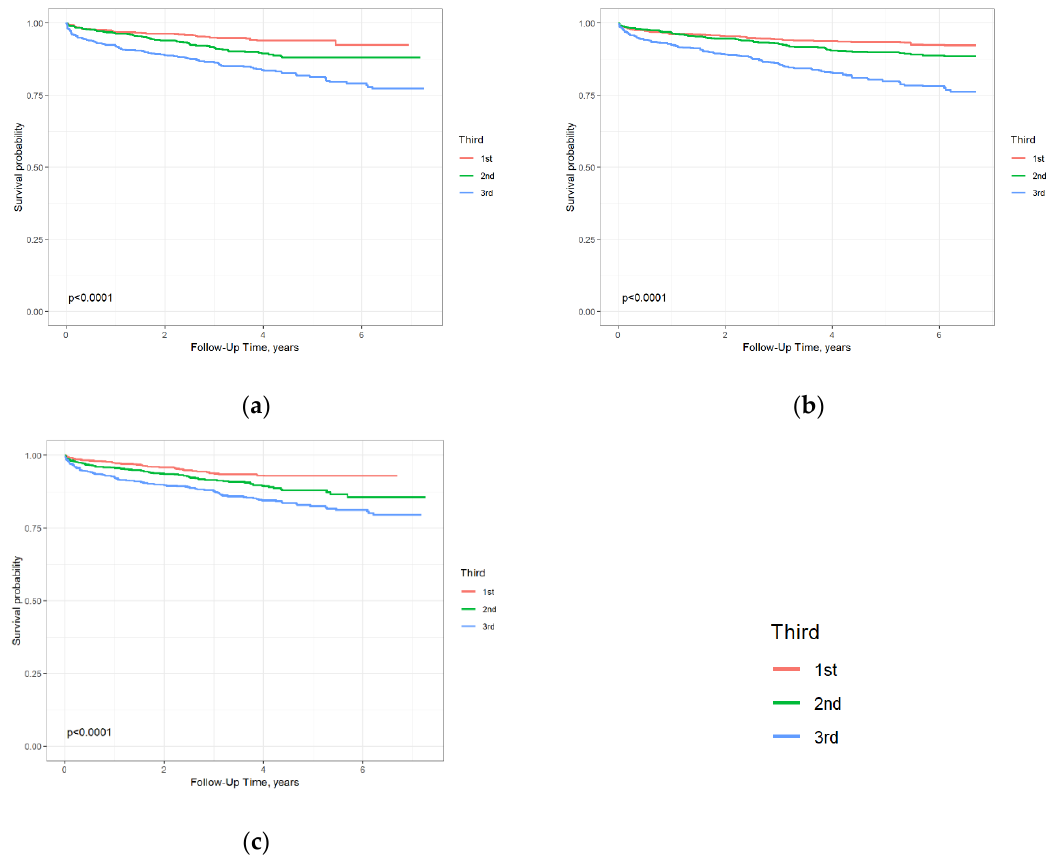
Figure 1. Survival curves for cardiovascular (CV) death and / or acute myocardial infarction (MI) according to tertiles of levels of hsTnI: ( a ) (1st tertile up to 5.20 ng / L; 2nd tertile up to 24.63 ng / L), NT-proBNP, ( b ) (1st tertile up to 132.74 pg / mL; 2nd tertile up to 418.14 pg / mL) and hsCRP, and ( c ) (1st tertile up to 2.04 mg / L; 2nd tertile up to 6.35 mg / L) in all. The p -values are for the logrank test.